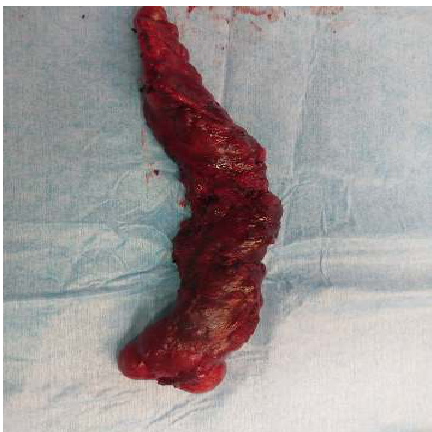
Figure 1: A macroscopic photograph showing of